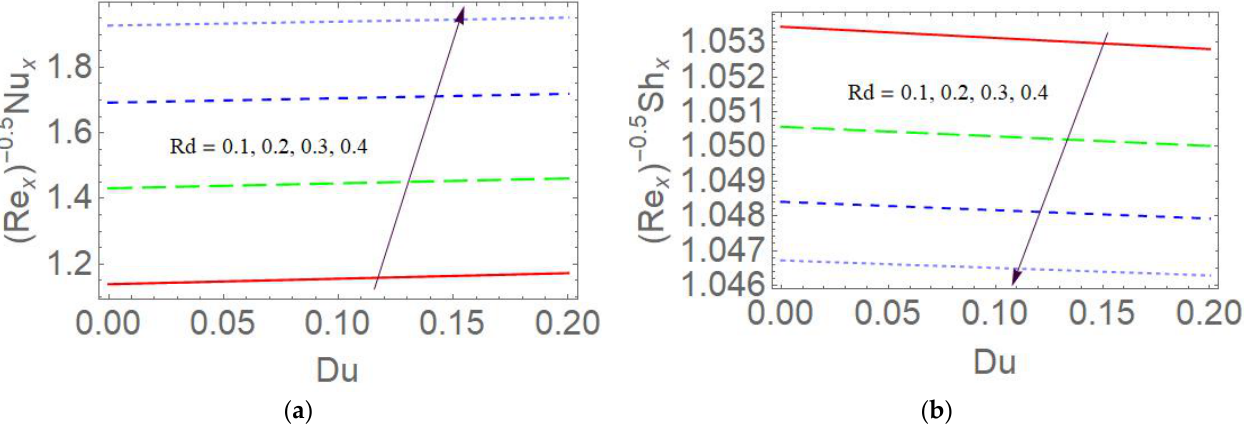
Figure 8. Impacts of ( a ) Rd on Nu